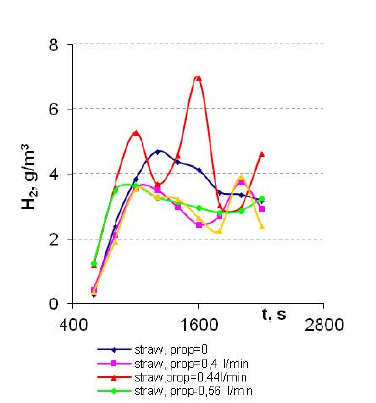
Figure 5. Effect of the propane supply on the CO concentration at the bottom of the combustor.